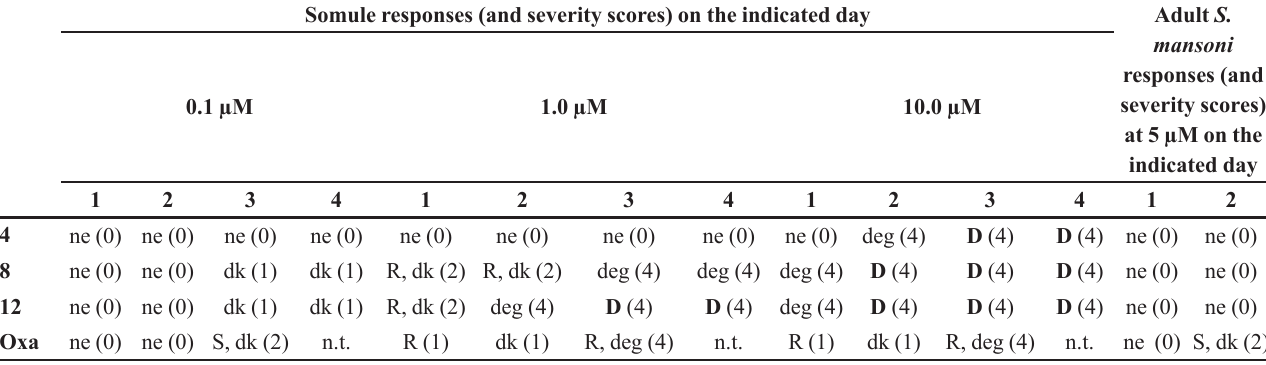
TABLE I – Descriptors a and severity scores b for the responses of S. mansoni somules and adults to nitrobenzyl compounds 4 , 8 and 12 Somule responses (and severity scores) on the indicated day Adult S.